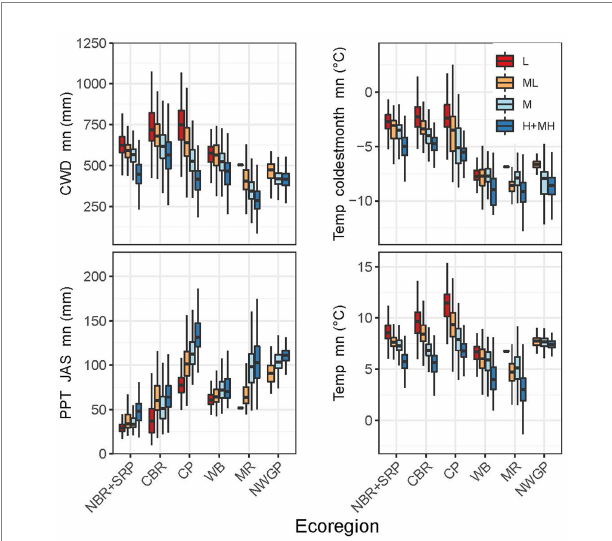
FIGURE 10 Boxplots for the most highly ranked predictor variables of resistance for each ecoregion by resistance category. Boxplot show the median at the box’s center, the first and third quartiles (25th and 75th percentiles) as the box’s hinges, and whiskers extending to the largest and smallest values. NBR, Northern Basin and Range; SRP, Snake River Plain;